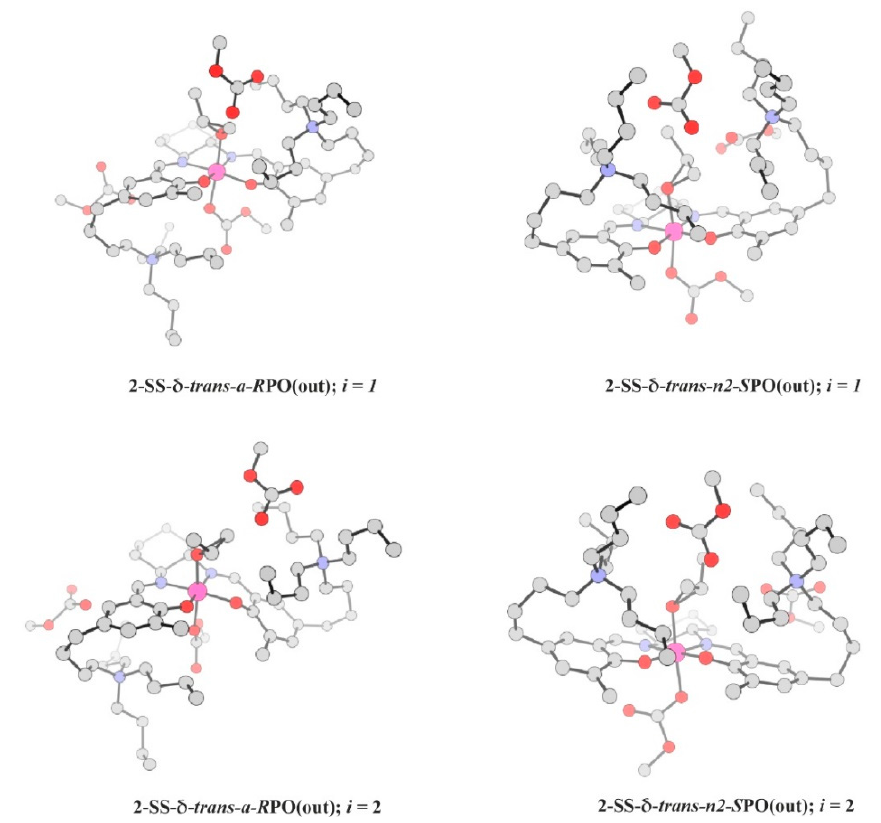
Figure 11. Structures of the most important transition states for R PO ‐ and S PO ‐ opening pathways in the case of 2 ‐ SS ‐δ‐ trans isomers. See also Table 4.